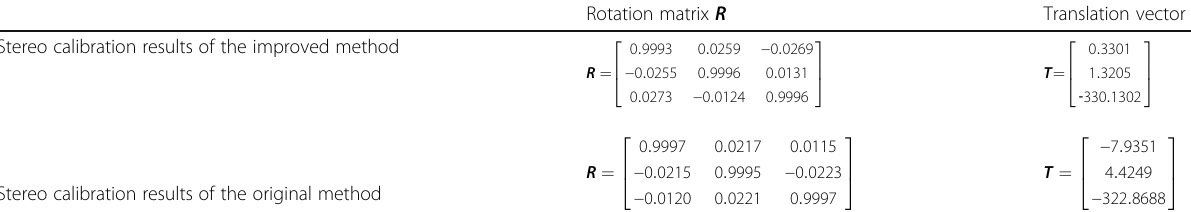
Stereo calibration results of the original